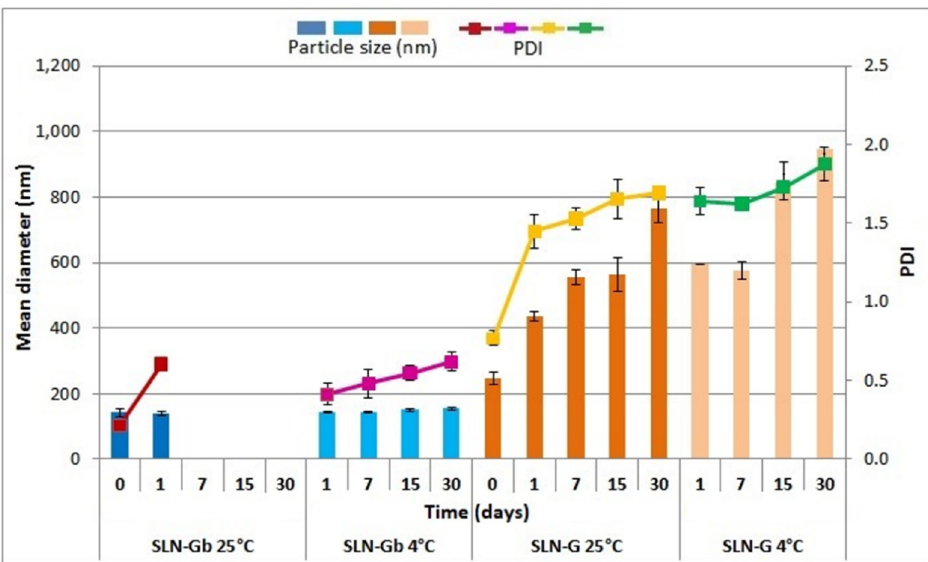
Figure 10. Influence of storage (at 4 and 25 °C) on the particle size and PDI of SLN-Gb and SLN-G. Particle size: SLN-G at 25 °C, 0 days vs. 1, 7, 15 and 30 days ( p < 0.05); SLN-G at 4 °C, 0 days vs. 1, 7, 15 and 30 days ( p < 0.05). PDI: SLN-Gb at 25 °C, 0 days vs. 1 day ( p < 0.05); SLN-Gb at 4 °C, 0 days vs. 1, 7, 15 and 30 days ( p < 0.05); SLN-G at 25 °C, 0 days vs. 1, 7, 15 and 30 days ( p < 0.05); SLN-G at 4 °C, 0 days vs. 1, 7, 15 and 30 days ( p < 0.05).